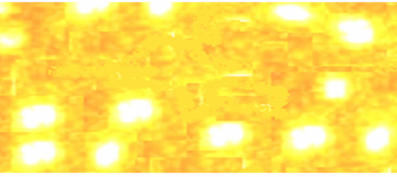
Figure 2. Improved image of the thermogram suitable for recognition after contrasting.